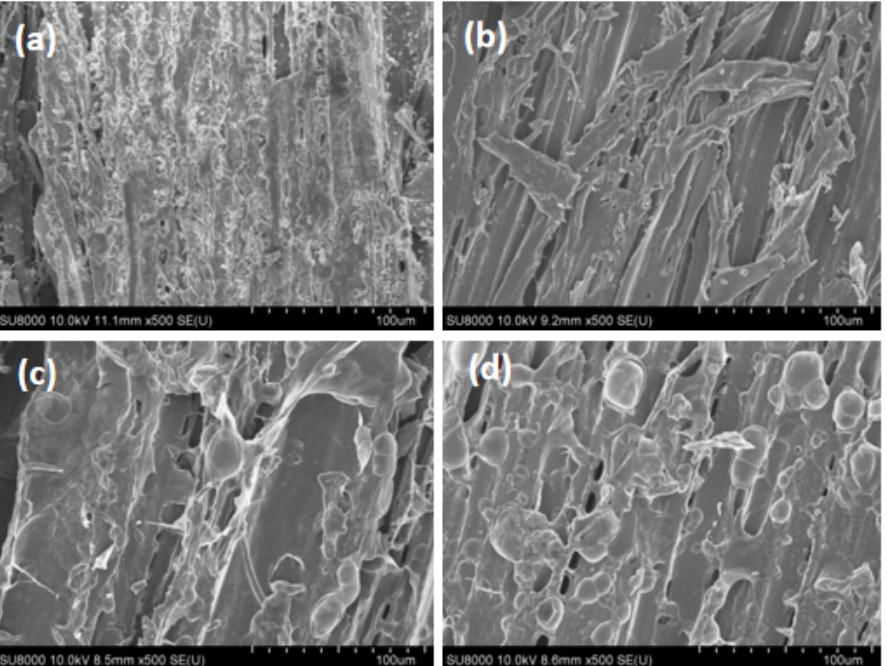
Figure 5. SEM images of different wood char after combustion, ( a ) control; ( b ) 2.5% GP modified; ( c ) 5.0% GP modified; ( d ) 10% GP modified.